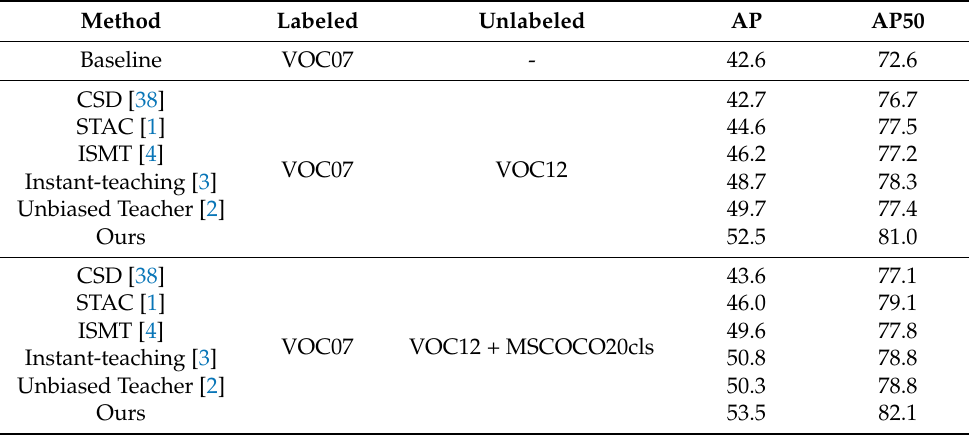
Table 2. Experimental results on the VOC